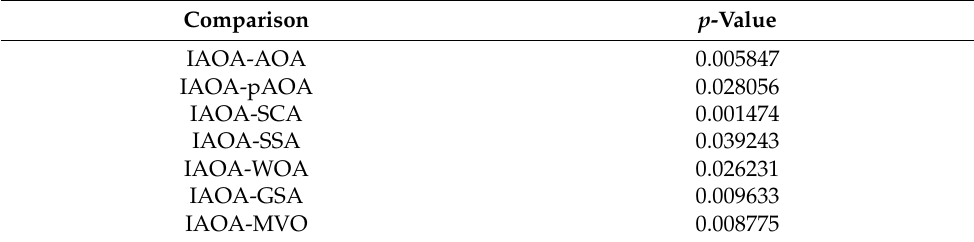
Table 3. Wilcoxon statistical test